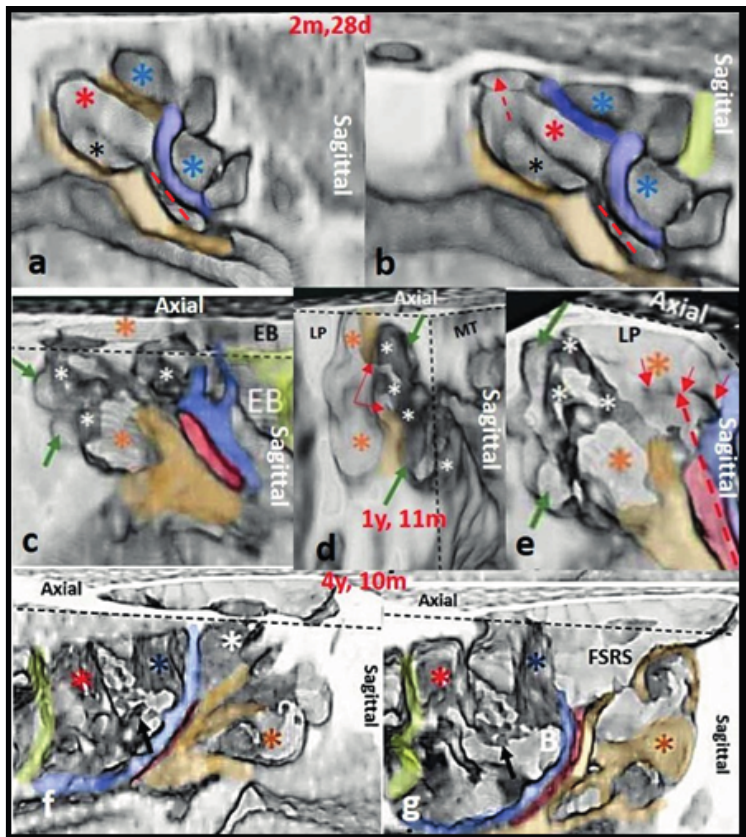
Figure 5. Expansion of ES space(s) and appearance of the “dark lamella”, at ages: 2months-28 days; 1 year-11 months; and 4years-10 months. a., b. 3D right sided sagittal obliqued images, reveal the medial surfaces of the UL (gold), and the EB (blue), as well as the MT Basal Lamella (yellow- green). Note the EI (red) and the communication of the EI with a more prominent space between the UL and EB, which appears to be segmented by an oval dark outline (black *). This is likely the origin of a spatial creation and separation between the emerging ISEUP (black asterisk) and the more superior space (red *), the emerging FR. Note the antero-superior extension of the potential FR. The EB space is denoted by blue asterisks. c.-e. 3D right sided oblique sagittal images in a 1 year, 11 month patient, reveal the medial surface of the UL (gold), BL (blue), and BaLa (yellow-green) folds. All the images reveal the developing medial outline of the UL. Note the “tattered” dark foci (white asterisks) which represent “bony islets” infil- trating the membranous construct of the UL. Note the presence of a larger space between the LP and the UL, best displayed in fig. (d), with two gold asterisks representing a united space between the ISEUP and the FR, at this stage. Also shown is a “gap” in the UL outline (joined red arrows). The space between the MT (MT) and the UL is the MM (green arrows). f., g. 3D left sided oblique sagittal images in a 4 year, 10 month old patient, showing the medial surface of the UL (gold), BL (blue), and BaLa (yellow- green). The images reveal a more solid “black lamella” area of the LP, between the BaLa and a lamella within the EB space (red asterisk),and on the LP, between the intermediate lamella and the BL (dark blue asterisk). There is also a similar dark area between the BL and UL (white asterisk). These rep- resent a more advanced development in the membranous bony evolution, which creates the LP, as the permanent lateral boundary of the Ethmoid Sinus. Also note the tattered dark foci within the EB space (black asterisk), representing “bony islets” infiltrating the membranous construct of the EB space. ISEUP (gold asterisk); and Frontal Sinus/Frontal Recess Space